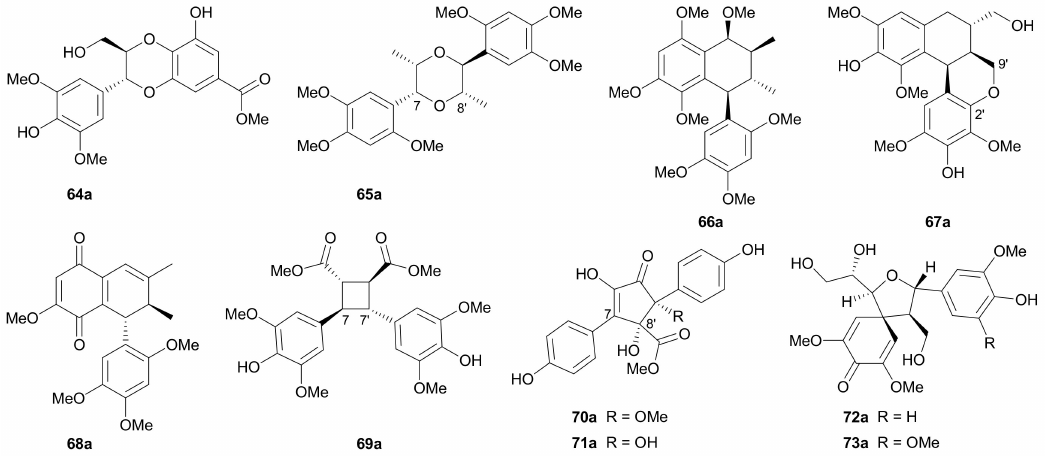
Figure 4. Structures of other cyclic